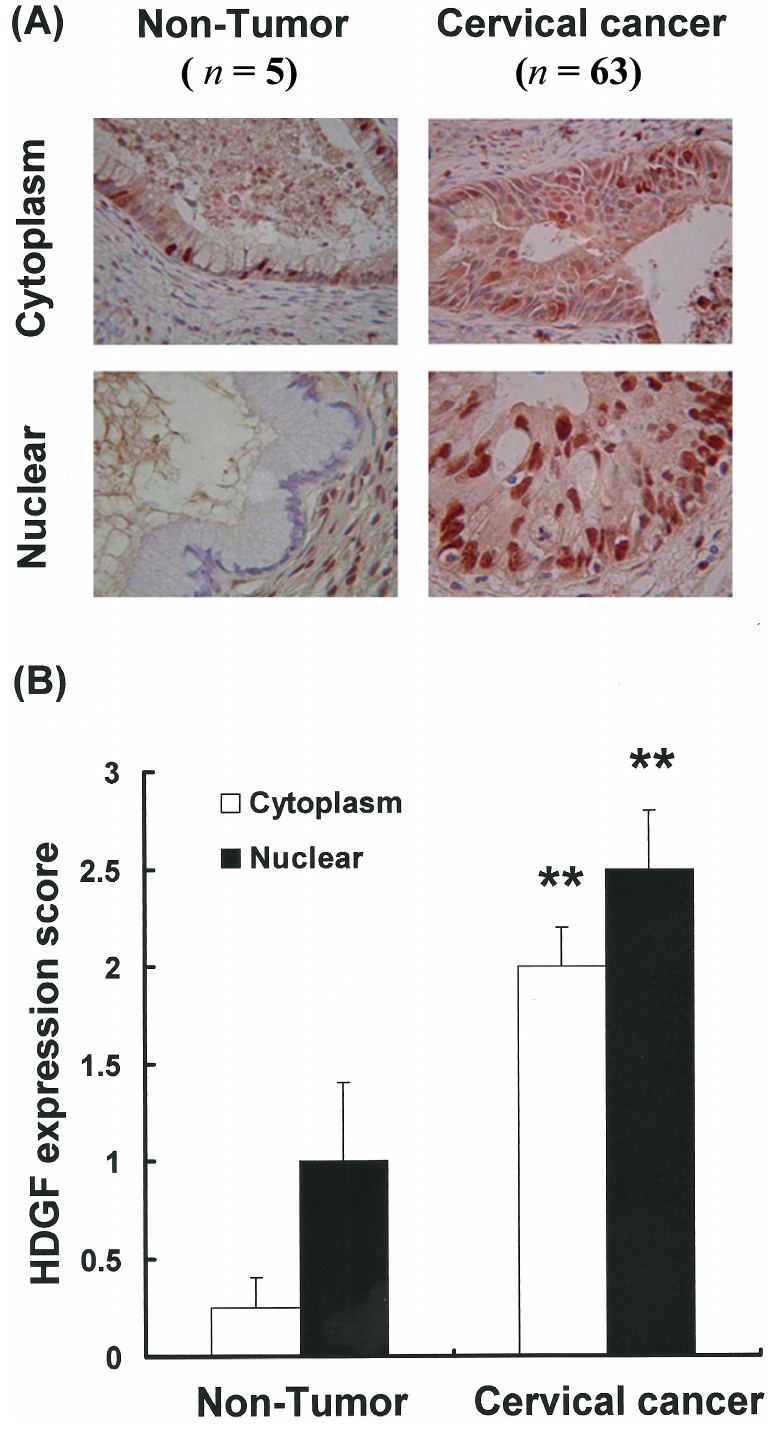
Figure 1. Differential nuclear and cytoplasm Hepatoma-derived growth factor (HDGF) expression in tumor and non-tumor specimens from patients with cervical adenocarcinoma (Cx). ( A ) HDGF expression in cervical cancer and non-tumor specimens from patients with Cx; ( B ) A higher percentage of HDGF-positive cells was found in the tumor regions than in the non-tumor regions. ** Indicates that the difference compared to the non-tumor samples was statistically significant at p <